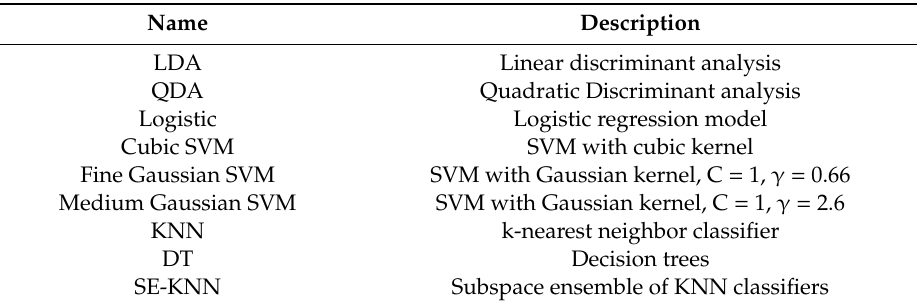
Table 3. Classification